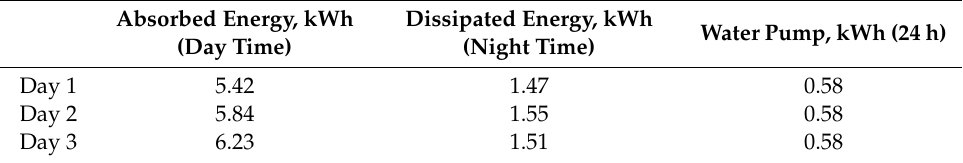
Table 2. Energy balance of the horizontal WFG.